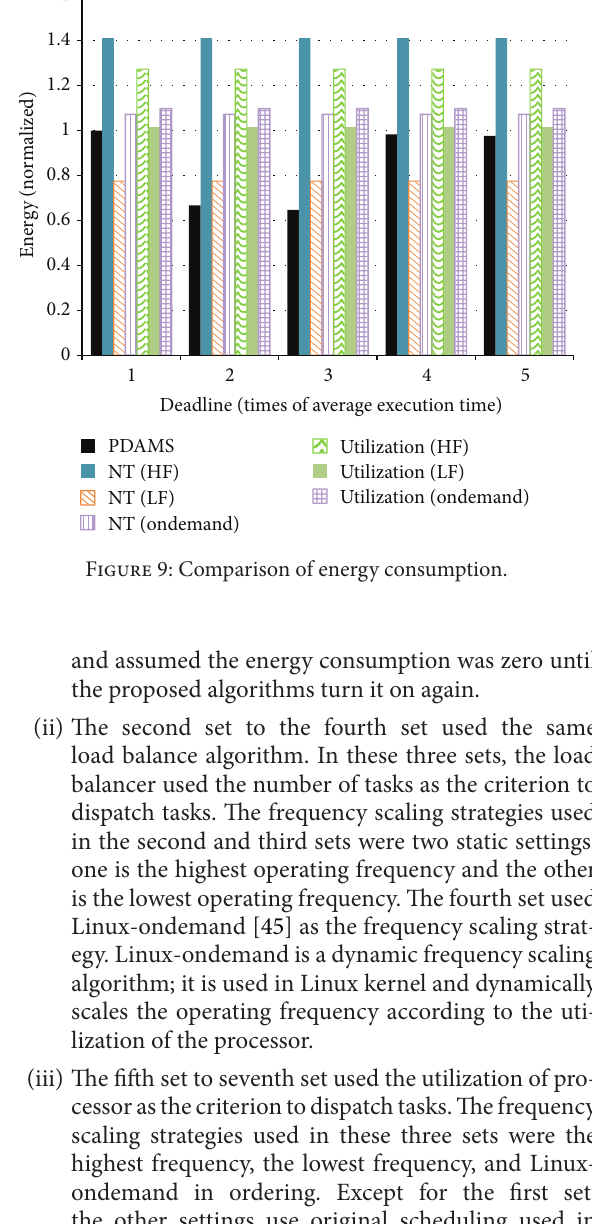
Table 2: Operating voltage and frequency of PACDSP.